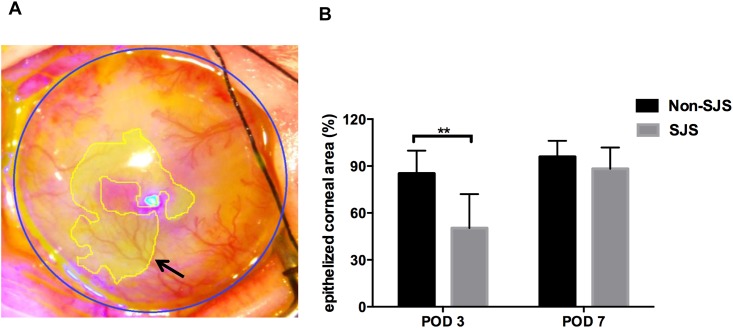
In vivo re-epithelialization by Stevens—Johnson syndrome (SJS) and non-SJS cultured oral mucosal epithelial cell sheets (COMECs) in a limbal stem cell-deficient model.(A) Digital measurement of the epithelial defect area (black arrow) and calculation of re-epithelialized corneal area. (B) The re-epithelialized area was smaller in SJS-COMECs than in non-SJS-COMECs at postoperative day (POD) 3 (**p<0.01, RM two-way ANOVA) but was not statistically different between SJS and non-SJS-COMECs on POD 7. SJS indicates cells from SJS subjects; non-SJS indicates cells from non-SJS subjects.